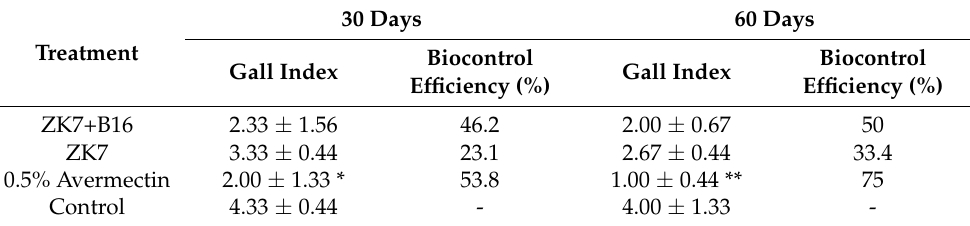
Table 5. Effect of different treatments on galls and biocontrol efficiency in roots of tomato (collected in pot experiments).